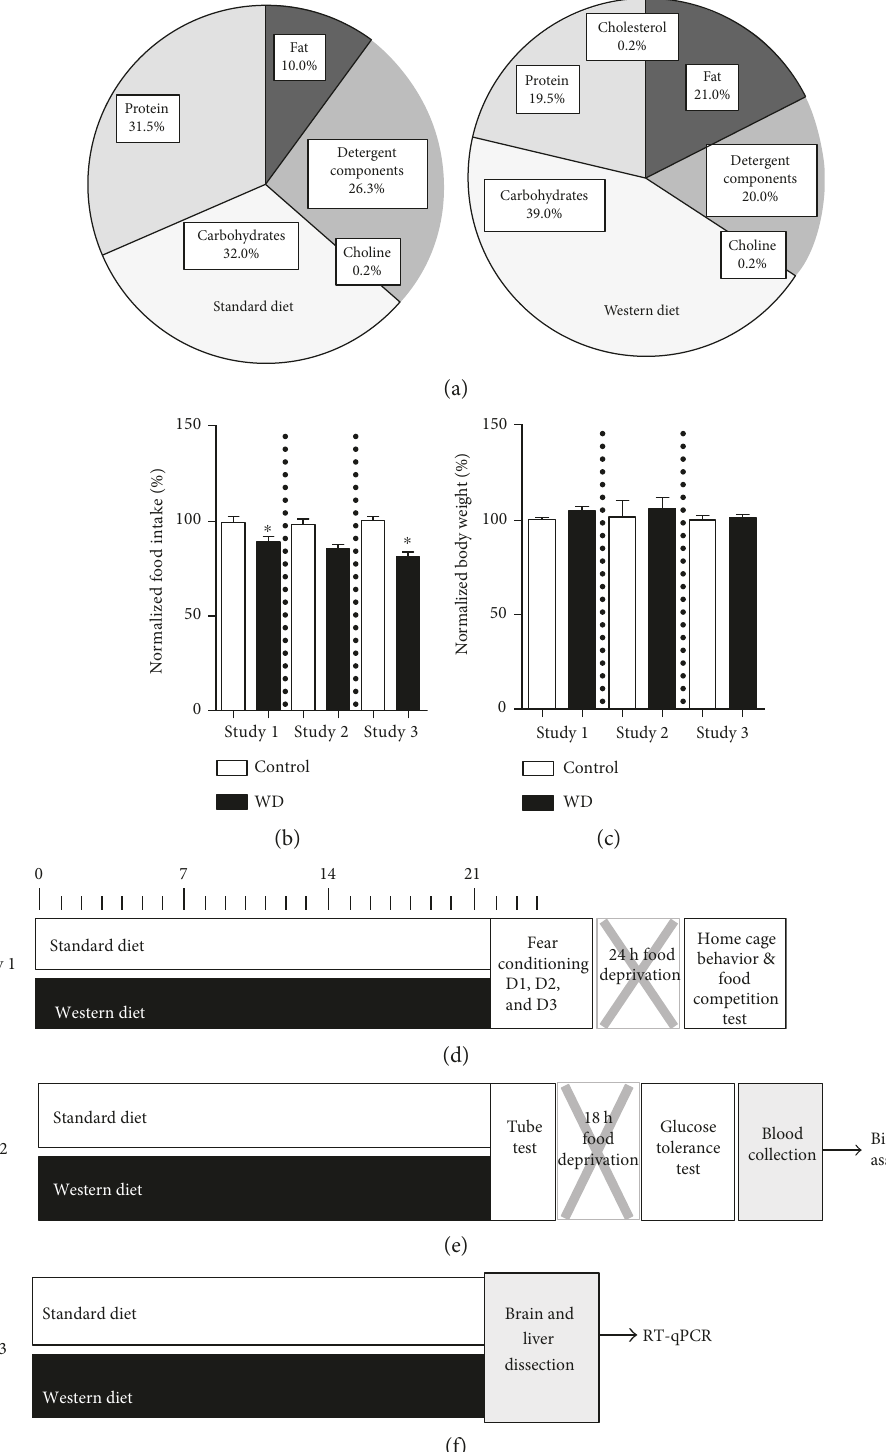
Figure 1: Experimental design. (a) Composition of the diets and percentage of total calories. Food intake (b) and body weight (c) normalized to control on day 21 of a dietary challenge (control: control diet, WD: high-cholesterol diet; ∗ p < 0 05 versus that in the control diet, t -test). (d) Study of the e ff ects of cholesterol-enriched diet exposure on mouse behaviour in fear conditioning test, home cage, and food competition test. (e) Study of the e ff ects of cholesterol-enriched diet exposure on mouse performance in pellet displacement tube test, glucose tolerance, and blood biochemical parameters. (f) Study of the e ff ects of cholesterol-enriched diet exposure on gene expression in the brain and